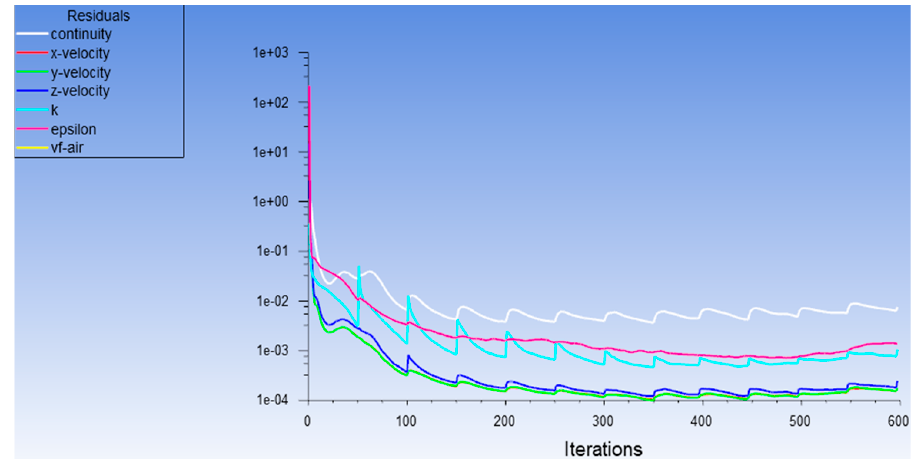
Figure 8. Analysis curve.